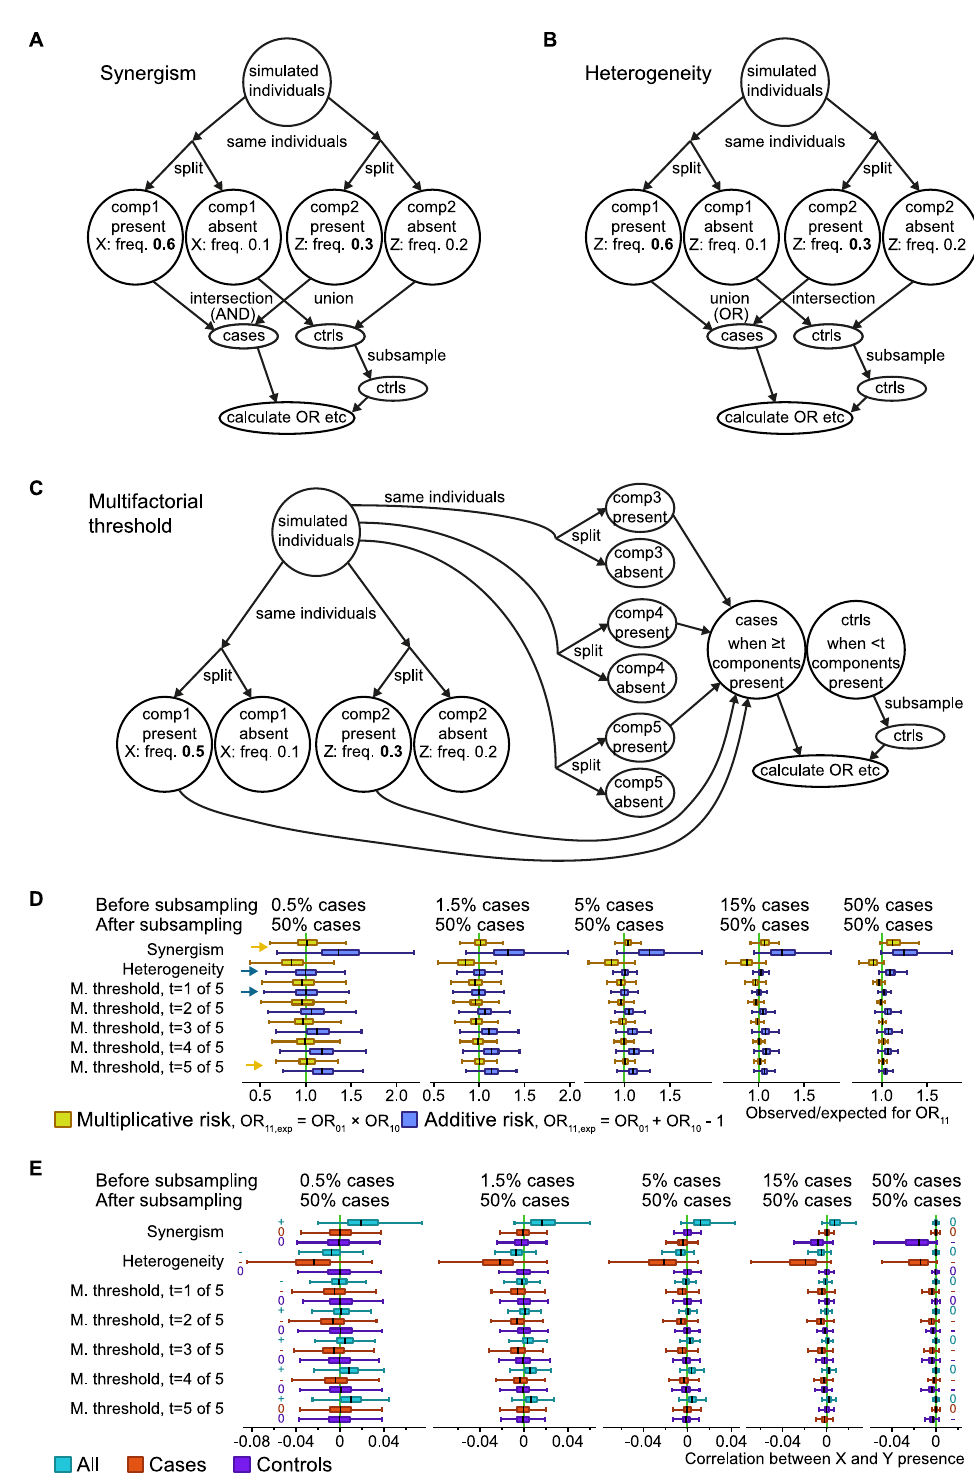
Fig 1. Three simulated causal scenarios with selection of equal numbers of cases and controls. A-C : Simulation schemes for three generalized scenarios in a case-control study context: Synergism of causes (A), heterogeneity of causes (B), and a multifactorial or 5-factor threshold (C). The numbers are example frequencies, and numbers in bold highlight the higher frequencies of the simulated risk factors (X and Z) associated with disease. For example, “Z: freq. 0.3” means that each simulated individual in the group had a 30% chance of being assigned the risk factor Z. Numbers in italic are